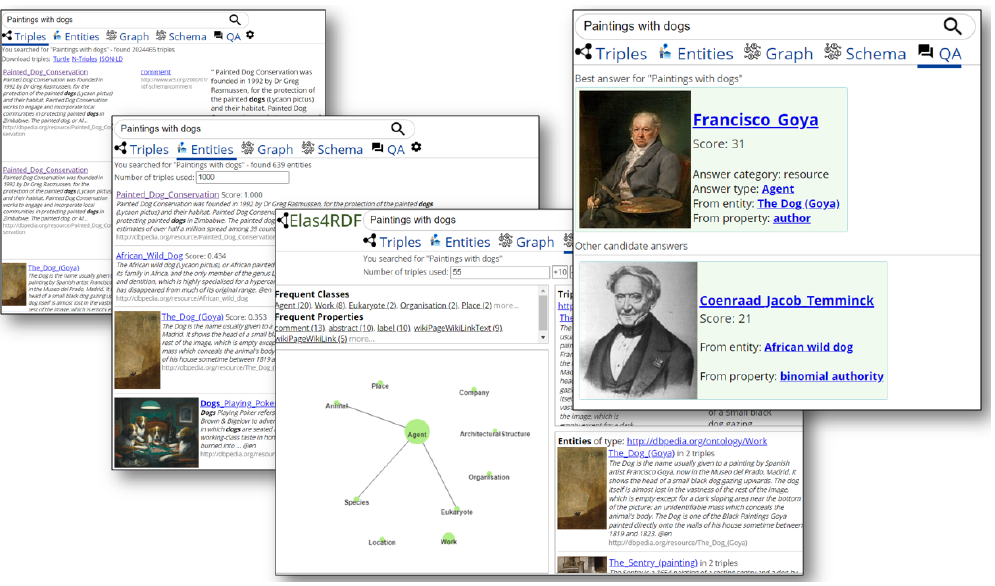
Figure 6. Search results for the query “ Paintings with dogs ”.